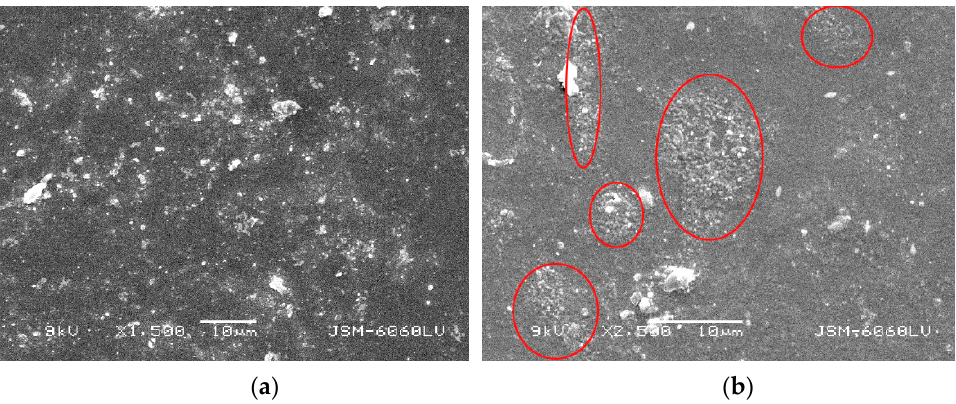
Figure 12. SEM images of photopolymer plate samples after swelling in methoxypropanol: ( a ) 10 × UV treatment, ( b ) 30 × UV treatment